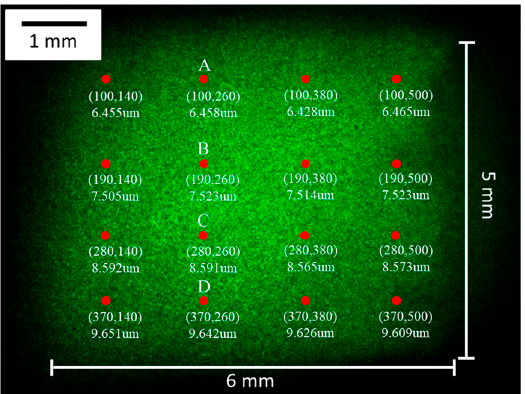
Figure 14. The final displacement map of the selected 16 pixels.